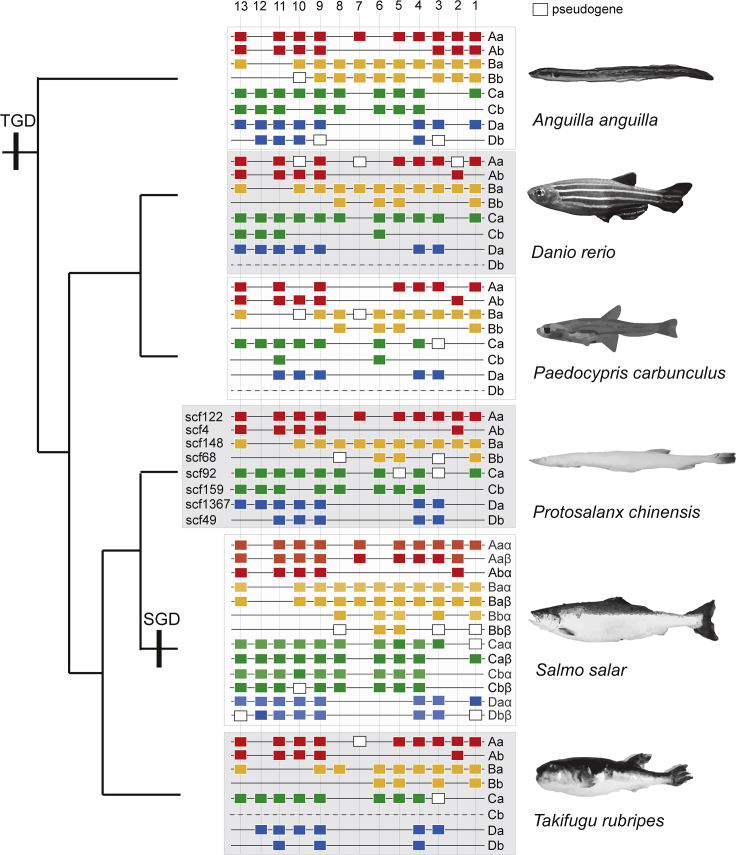
Phylogeny of Hox Gene Clusters of Six TeleostsOverview of the Hox gene clusters of Anguilla anguilla (European eel) (Minegishi et al., 2005), Danio rerio (zebrafish) (Bian et al., 2016), Paedocypris carbunculus (a dwarf minnow; common name yet to be assigned) (Malmstrom et al., 2018), Protosalanx chinensis (Asian icefish), Salmo salar (Atlantic salmon) (Mungpakdee et al., 2008), and Takifugu rubripes (fugu) (Bian et al., 2016). Each horizontal black line refers to a Hox cluster. Solid rectangles represent complete HoxA (red), HoxB (orange), HoxC (green), and HoxD (blue) genes, whereas hollow rectangles indicate pseudogenes or partial genes. Paralogs generated by TGD (a teleost whole-genome duplication event) are denoted “a” and “b,” whereas paralogs produced by lineage-specific SGD (a salmonid whole-genome duplication event) are denoted “α” and “β.” See also Table S17.